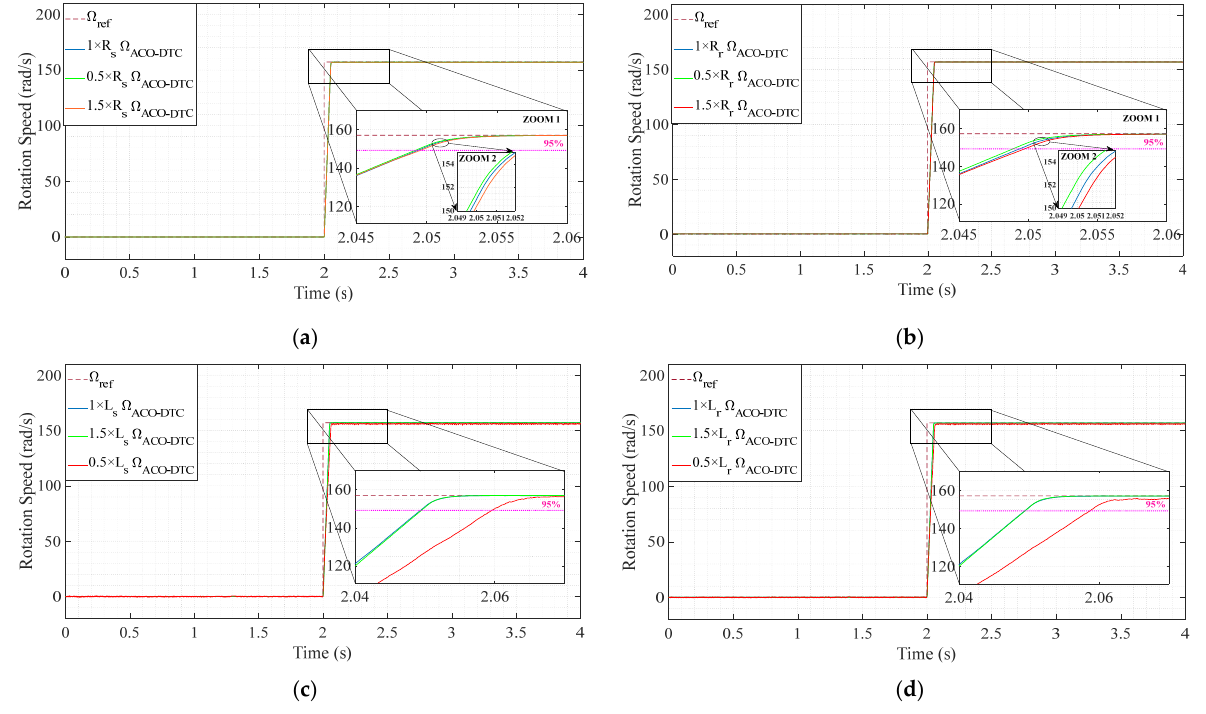
Figure 18. Speed response during variation of ( a ) stator and ( b ) rotor resistance and ( c ) stator and ( d ) rotor inductance of ACO-DTC.